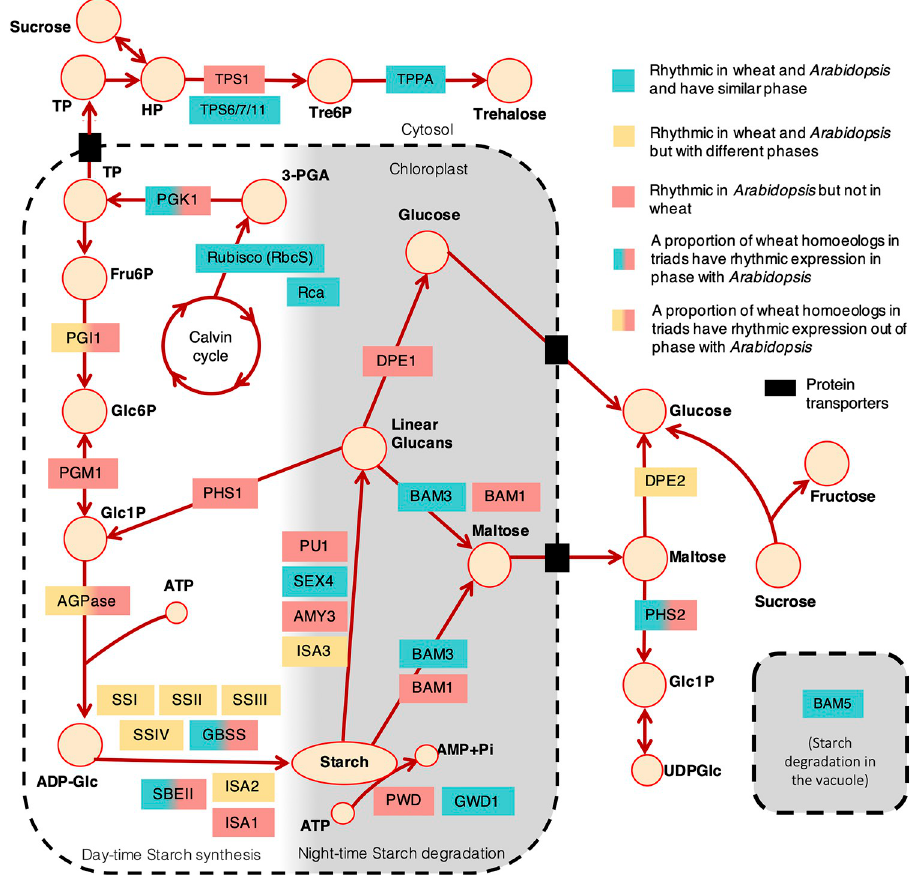
Fig 5. Similarities and differences in circadian control of transcript accumulation in key genes involved in primary metabolism and signalling. Circles represent metabolites involved in the breakdown and biosynthesis of starch. Starch synthesis occurs during the day and breakdown occurs at night as indicated by the white to grey shading gradient. The dotted line encloses processes that take place in the chloroplast or vacuole. HP, Hexose-phosphate; Tre6P, Trehalose-6-phosphate; TP, Triose phosphate; 3-PGA, Glycerate 3-phosphate; Fru6P, Fructose-6-phosphate; Glc6P, Glucose-6-phosphate; Glc1P, Glucose-1-phosphate; ATP, Adensoine tri phosphate; ADP-Glc, ADP-glucose; TPS, Trehalose phosphate synthase; TPP, Trehalose phosphate phosphatase; PGK1, Phosphoglycerate kinase 1; PGI1, Glucose-6-phosphate isomerase; PGM1, Phosphoglucomutase-1; PHS1 and 2, ALPHA-GLUCAN PHOSPHORYLASE 1 and 2; AGPase, ADP-Glc pyrophosphorylase; BAM1,3,5, β -amylase 1,3,5; ISA1,2,3, Isoamylase 1,2,3; DPE1,2, Disproportionating enzyme1 and 2; SBEI,II, Starch branching enzyme I, II; PU1, Pullulanase 1; PWD, Phosphoglucan, water dikinase; GWD, α -glucan, water dikinase; SEX4, starch excess 4; AMY3, α -amylase; GBSS, Granule bound Starch synthase; SSI-IV, Starch synthase I-IV; UDPGlc, UDP-glucose. Pathway references: